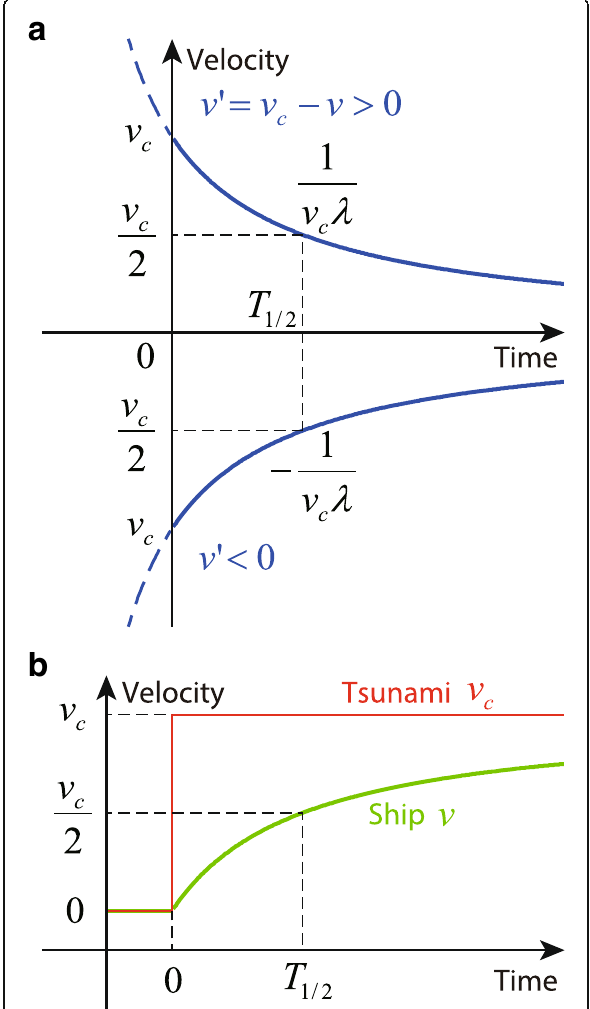
Fig. 6 Time evolution of a the solution of Eq. (6), and b tsunami velocity (red) and associated response of ship velocity (green). T 1/2 is time when v = v c